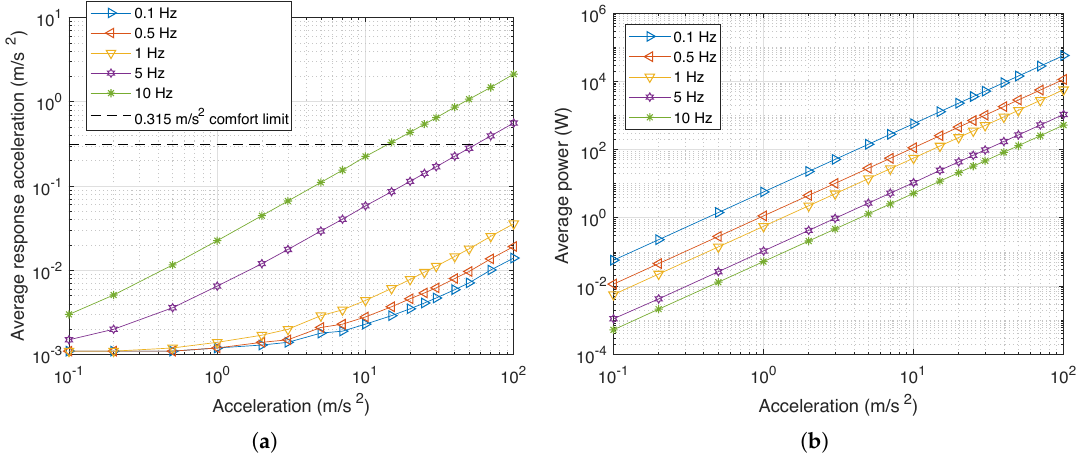
Figure 5. The average response of the magnetic suspension when subjected to sinusoidal excitation between 0.1 Hz and 10 Hz, as well as between 0.1 m/s 2 and 100 m/s 2 . ( a ) Response acceleration (comfort level); ( b ) recoverable power from suspension.